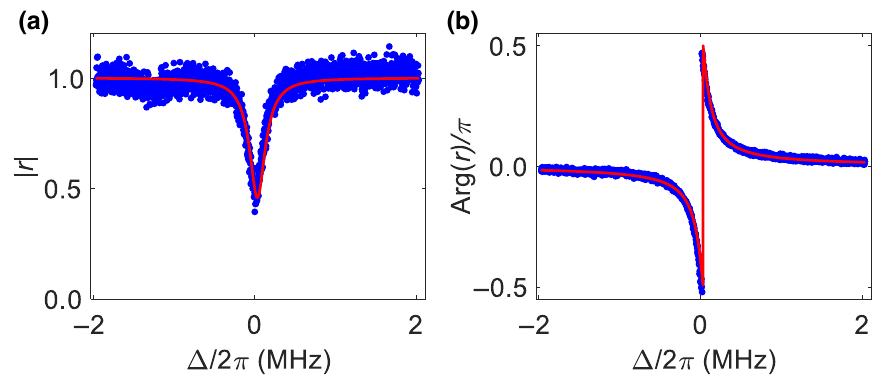
FIG. 2. Weak-power spectroscopy under a coherent drive: (a) magni- tude and (b) phase response of the reflection coefficient r as a function of the probe detuning. Blue dots are the experimental data with the red solid curves calculated from Eq.